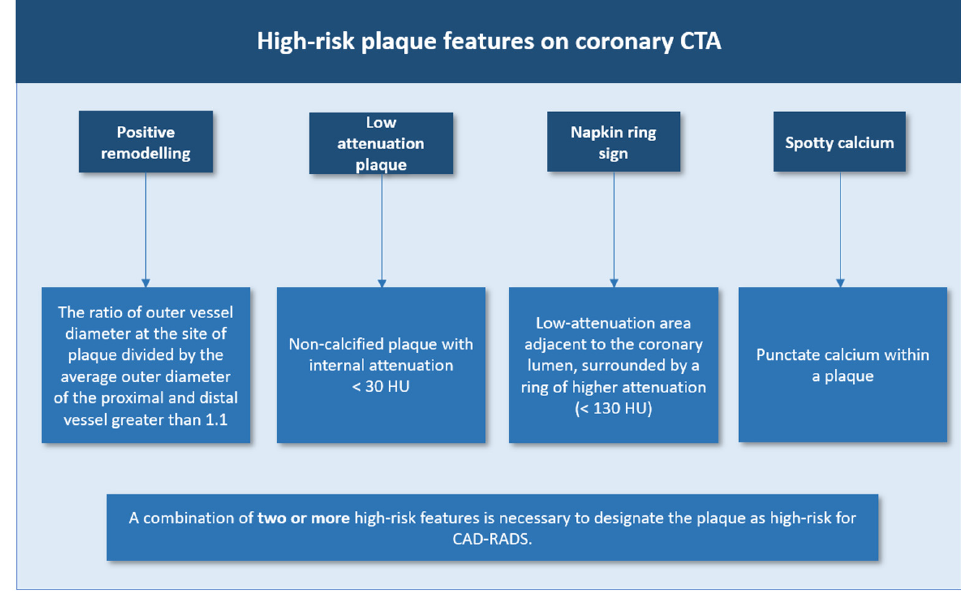
Figure 2. Coronary artery stable plaques: ( a ) calcific plaque; ( b ) fibro-calcific plaque .